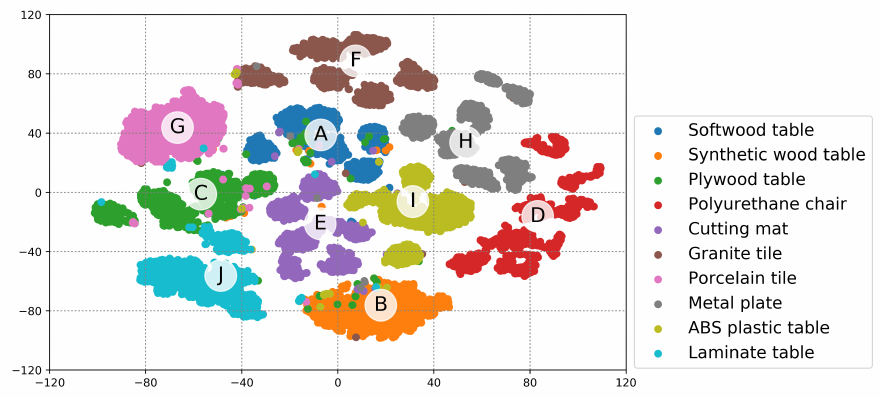
Figure 10. An example of 2-D embedding of the network output of the test dataset used in this study using t-distributed stochastic neighbor embedding (t-SNE) [39] when GRU-based architecture was employed for